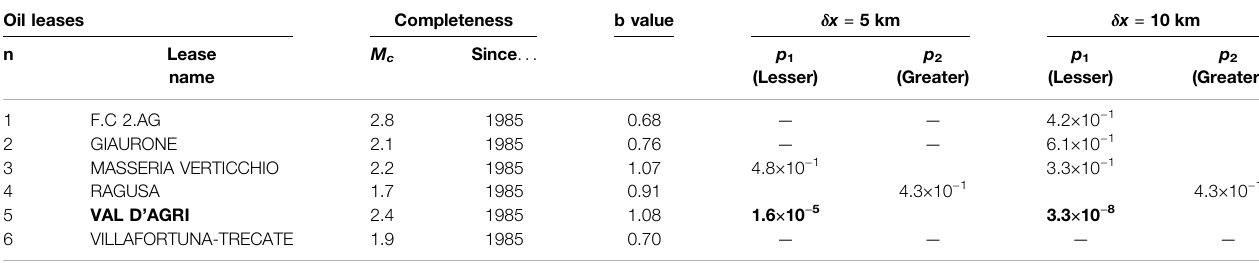
TABLE 1 | Oil-producing leases analyzed in this study. For each lease we present the estimated completeness magnitude, the b value, as well as the p values ( p 1 and p 2 ) of the binomial test performed considering the seismicity located within a distance δ x (cid:1) 5 and δ x (cid:1) 10 km (the symbol — indicates cases in which both the seismicity rate in both the pre- and the post- t m time windows are